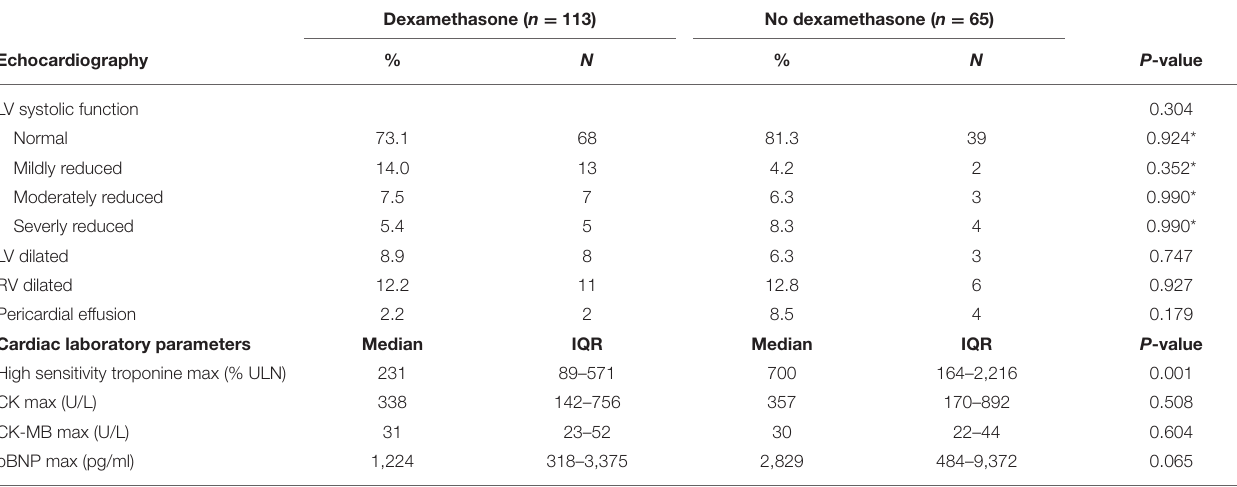
TABLE 2 | Parameters of cardiac function and cardiac laboratory parameters of patients treated with dexamethasone vs. controls. Dexamethasone ( n = 113) No dexamethasone ( n = 65)